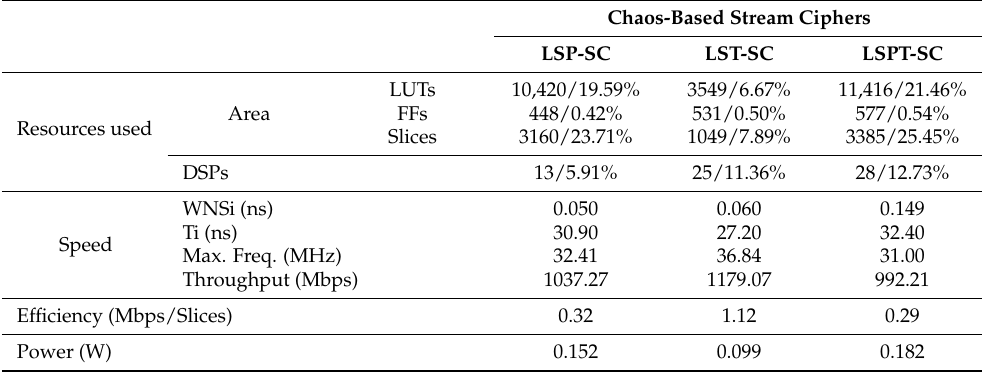
Table 12. Hardware metrics results of the proposed chaos-based stream ciphers.